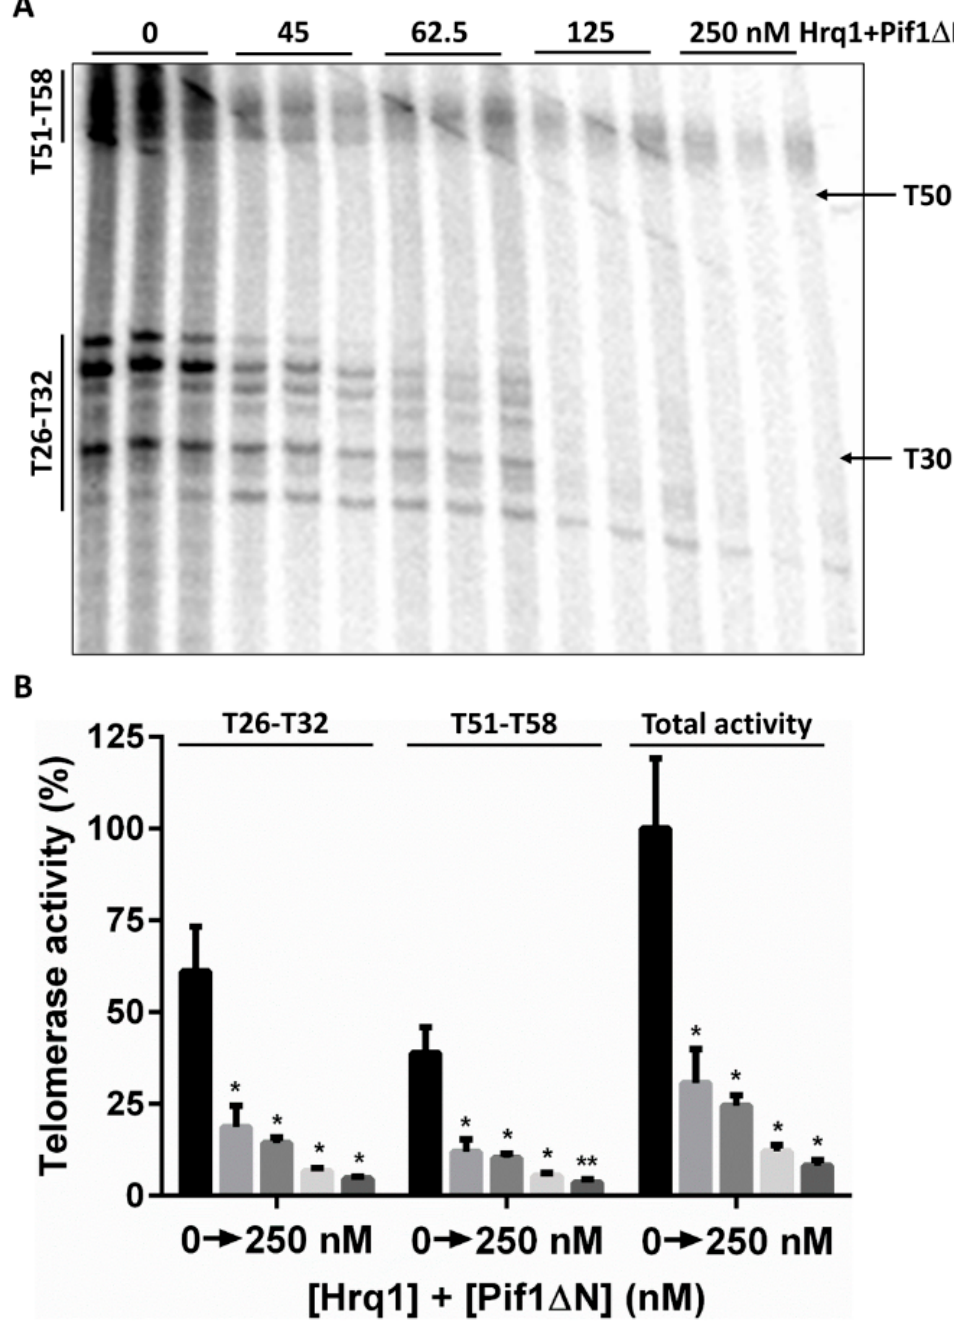
Figure 6. Hrq1 and Pif1 Δ N are still able to interact to regulate telomerase activity. ( A ) In vitro telomerase extension of the Tel50 substrate in the absence or presence of the indicated concentration of both recombinant Hrq1 and Pif1 Δ N (e.g., 45 nM indicates that 45 nM of each helicase was added). The direct extensions (Type I; T51–T58) and nuclease-cleaved extension products (T26–T32) [14] are noted on the left. The positions of the Tel30 and Tel50 markers are shown on the right. ( B ) Quantification of the telomerase activity shown in (A); mean values and standard deviation are shown. Total activity refers to the total amount of signal in the lanes. Significant differences were determined by multiple t tests using the Holm–Sidak method, with α = 5% and without assuming a consistent SD ( n = 3). *, p < 0.01 and **, p < 0.001; all comparisons were made against the reactions lacking added helicase.